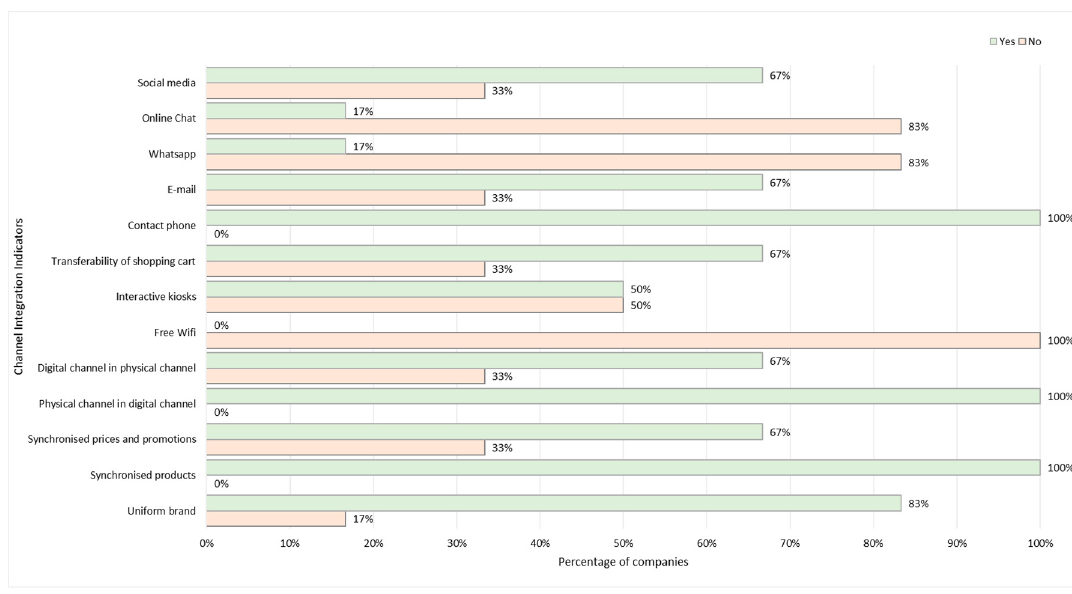
Figure 5. Indicators of channel integration across free-market Spanish national electricity retailers.